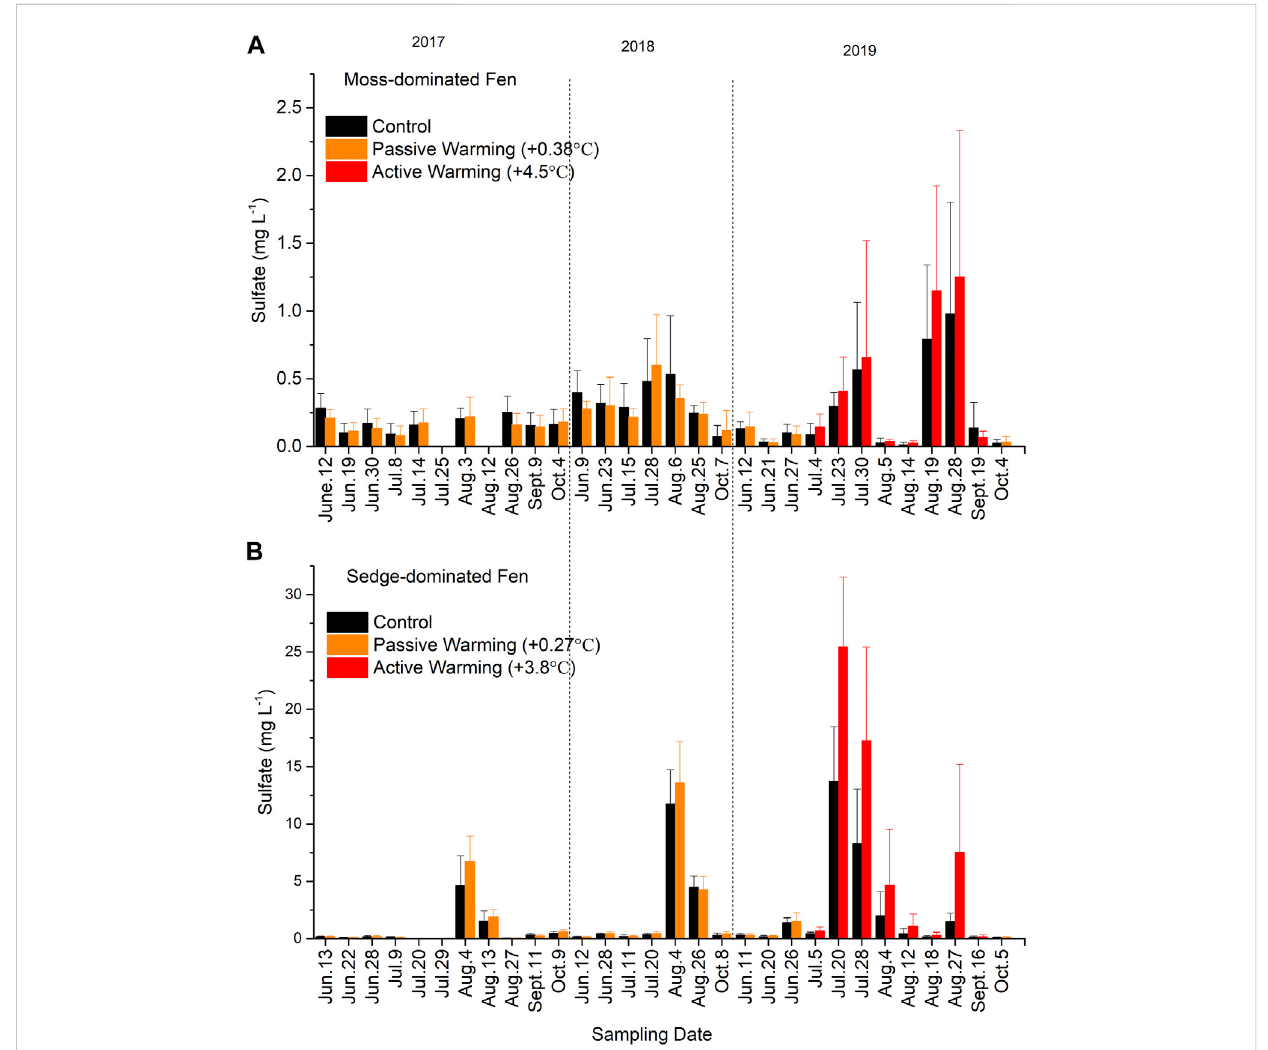
FIGURE 4 Sulfate (SO 4 2 − ) concentrations in (A) the moss-dominated fen and (B) the sedge-dominated fen. Colors are different plot treatments: black for the control plots; orange for the passively warmed plots; red for the actively warmed plots. Bars are mean values and whiskers are ± one standard deviation. Note differences in y -axis